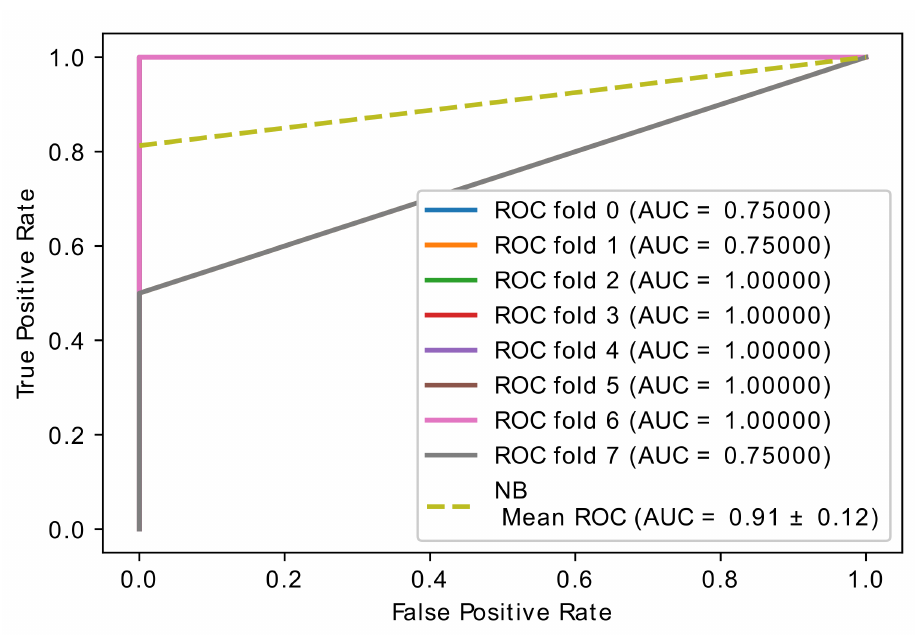
Figure 10. Accuracy curve of NB classifier. Table 7. Gene accession number and gene description of the selected genes of brain cancer by the proposed hybrid model. Prob